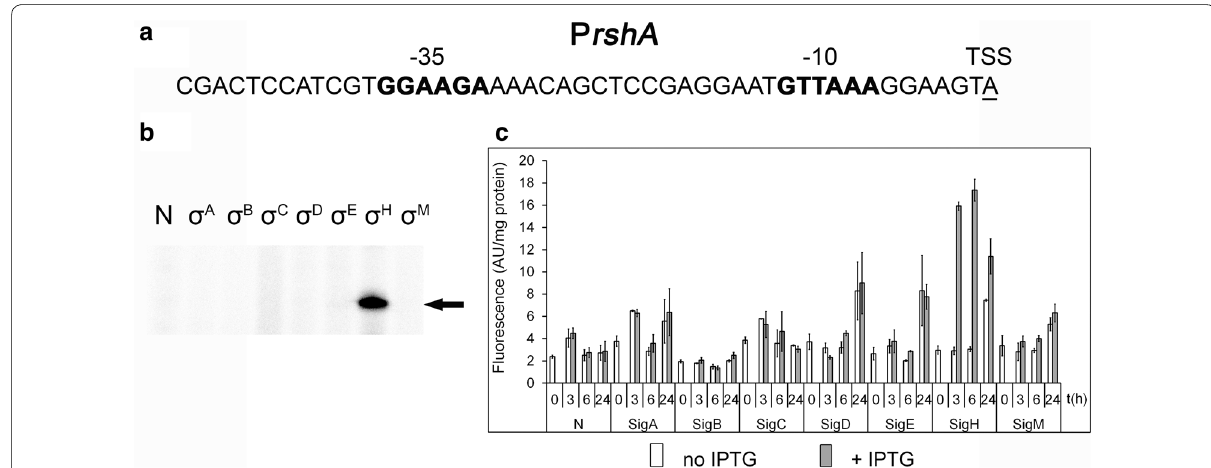
Fig. 1 Assignment of a sigma factor to the P rshA promoter. a Sequence of the rshA ( cg0876 ) promoter (Pfeiffer-Sancar et al. 2013). The 10 sequence elements are in bold , the transcriptional start site is underlined . b In vitro transcription with P rshA as a template. Individual sigma − factors associated with RNAP are shown at the top . N no sigma factor protein was added to the RNAP core. The specific transcript is indicated with an arrow . c P rshA activity determined with the two-plasmid system in C. glutamicum ∆ sigH by measuring the fluorescence intensity of the Gfpuv reporter. The sigma factors whose genes were overexpressed are indicated at the bottom . IPTG was added at time 0. AU arbitrary units. The standard deviations (SDs) of three measurements are depicted as error